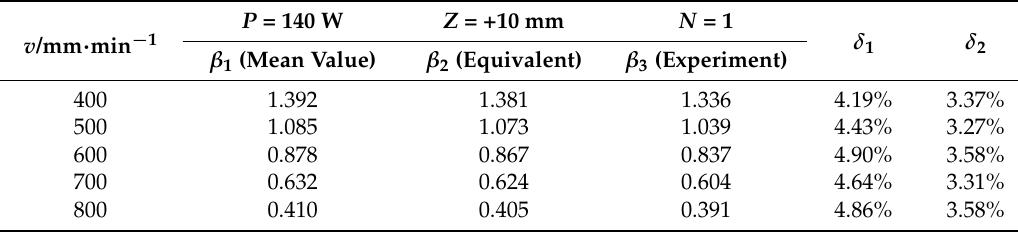
Table 5. Comparison of bending angle and error between the mean value method and the equivalent method with different scanning